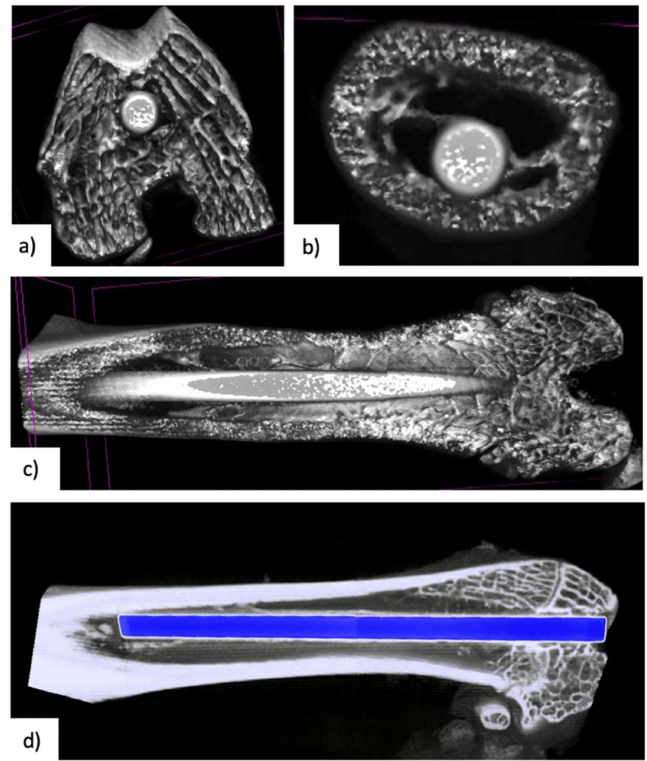
Figure 4. Images obtained following micro-CT examinations: ( a ) cross-sectional view of the in- tramedullary nail at the distal epiphysis; ( b ) cross-sectional view of the intramedullary nail at the middle of the femoral diaphysis; ( c ) longitudinal view of the intramedullary nail; ( d ) longitudinal view of the intramedullary nail with automatic detection of the metal implant by the software.